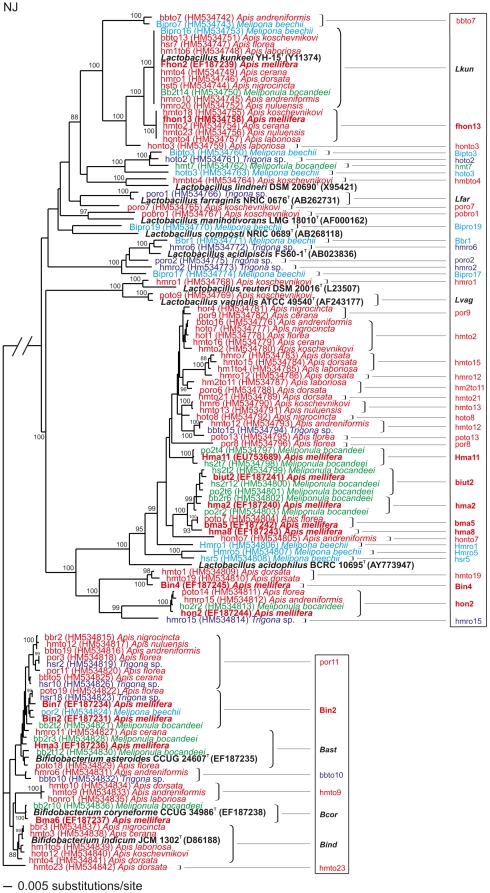
Phylogenetic tree of LAB in bee crops.Phylogenetic tree based on a distance matrix of positions 56–1470 (Escherichia coli numbering) in the 16S rRNA gene of Lactobacillus and Bifidobacterium spp. bacteria from Apis species (red) and the stingless bees Melipona beechii (turquoise), Meliponula bocandeii (green) and Trigona sp (blue). Previously characterized bacterial phylotypes from Apis mellifera are in bold print (red). Bacterial type strains are in bold characters (black). Phylotypes in the framework (right) represent different clusters belonging to a characterised or possibly novel species. Bifidobacterium group is the out-group. Bar: 5 base pair changes. 16S rRNA gene sequences deposited in GenBank HM534742–HM534842 (in parenthesis).